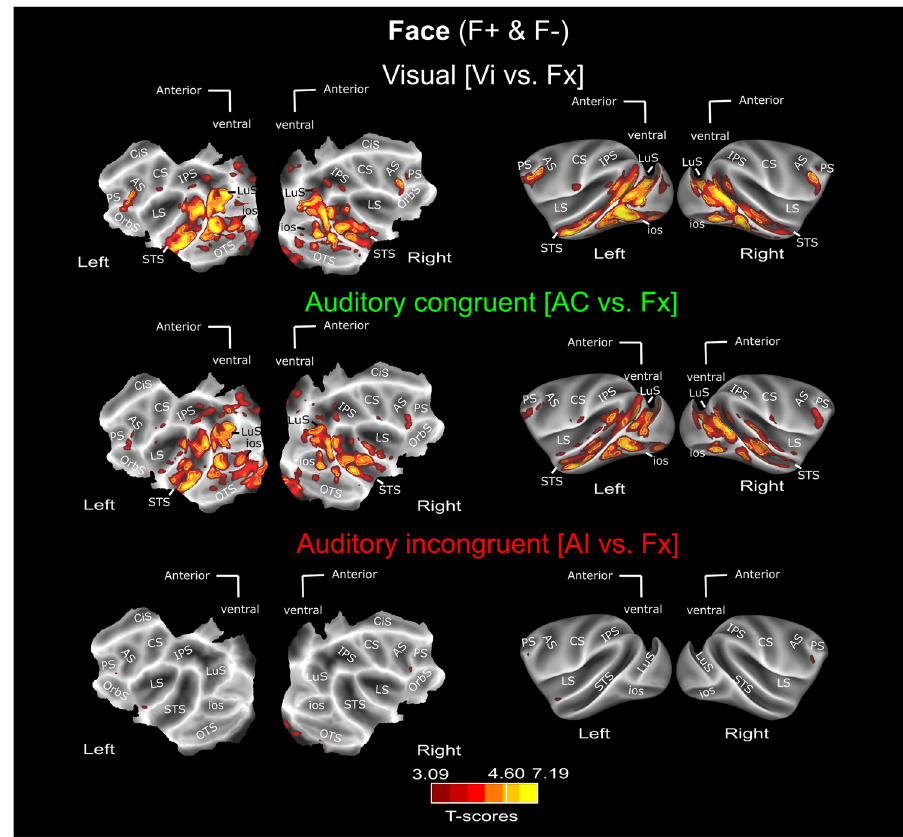
Fig.2| Whole-brainactivationFACEcontexts(F+&F − ):maincontrasts. Whole- brain activation maps of the F+ (face af fi liative) and F − (face aggressive) runs, cumulated over both monkeys, for the visual (white, Vi vs. Fx),auditory congruent (green,ACvs.Fx)andauditoryincongruent(red,AIvs.Fx).NotethattheACandAI conditions contain exactly the same sound samples (coos and aggressive calls). Darker shades of red indicate level of signi fi cance at p <0.001 uncorrected, t - score>3.09. Lighter shades of yellow and brown outlines indicate level of